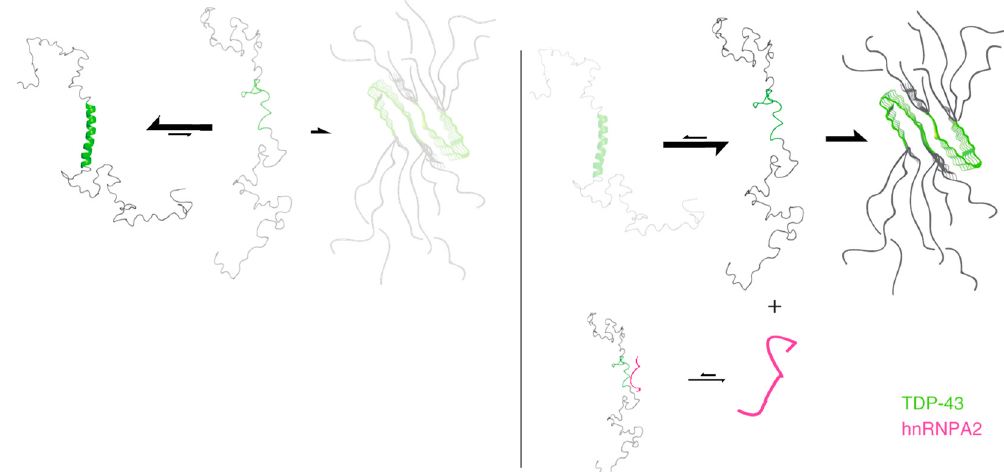
Figure 5. A schematic illustration of the proposed model. In the absence of hnRNP-A2, the IDR of TDP-43 is in equilibrium with both α -helix and coil conformations but tends to aggregate in its coil form (left panel). When the α -helical region of TDP-43 ′ s IDR weakly contacts the IDR of hnRNP-A2 (pink), the coil population of TDP-43 is increased, which enhances its tendency to aggregate (right panel).